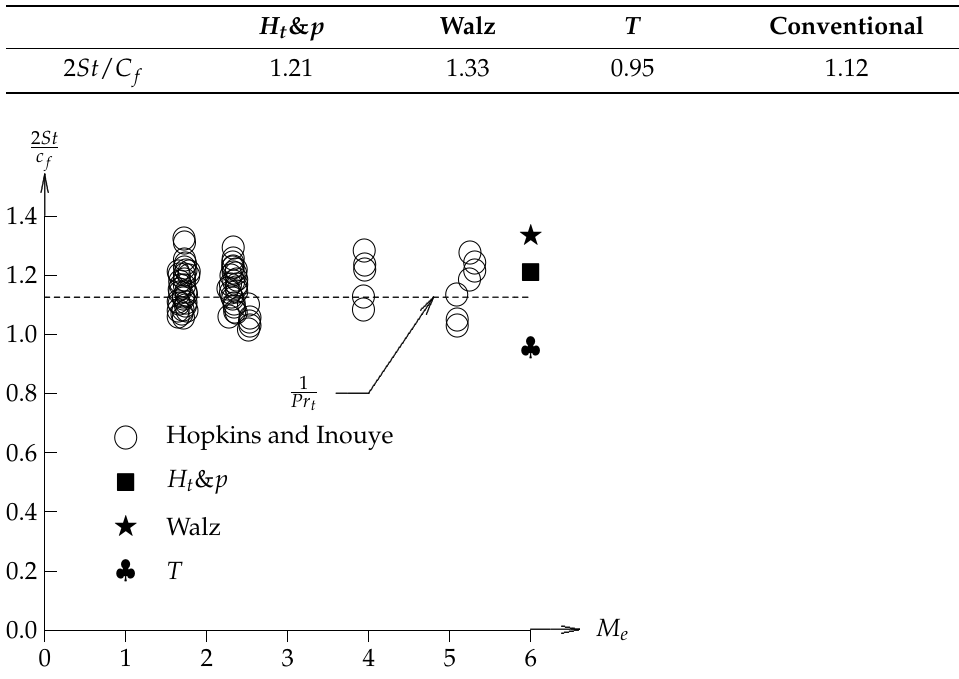
Table 3. Effect of recycling-rescaling method on Reynolds Analogy Factor (2 St / C f ) for condition No. 2.